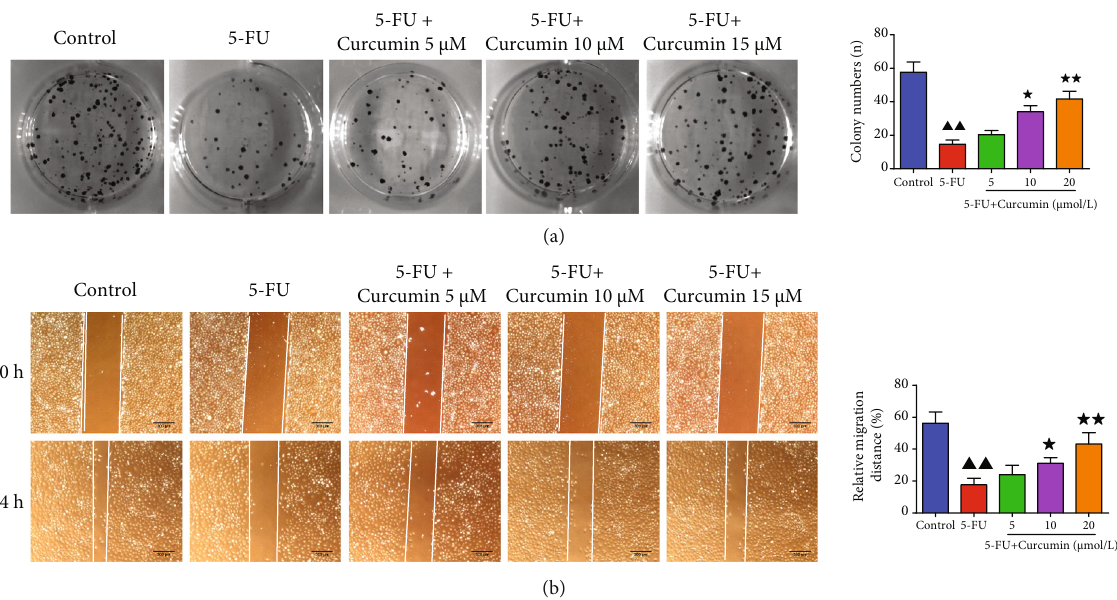
Figure 3: E ff ect of curcumin on the cloning ability and migration of the 5-FU-stimulated IEC-6 cells. IEC-6 cells were stimulated with 5-FU for 24h and then further treated with curcumin at 5, 10, and 20 μ mol/L for 24 h. (a) Colony formation assay was performed to detect the cell colony ability of each group cells. (b) Wound healing assay was performed to detect the cell migration distance from 0h to 24 h of each group cells. Data were expressed as mean ± standarderror mean (SEM), ▲▲ p value < 0.01 vs. control group; ∗ p value < 0.05 vs. 5-FU group; ∗∗ p value < 0.01 vs. 5-FU group. 5-FU: 5- fl